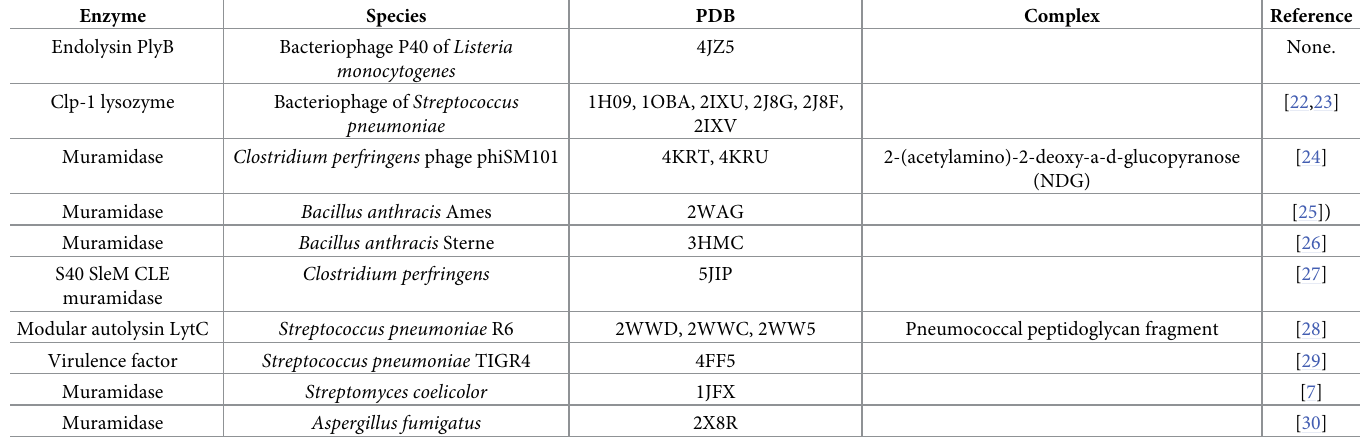
Table 1. Structures of family GH25 muramidases in the